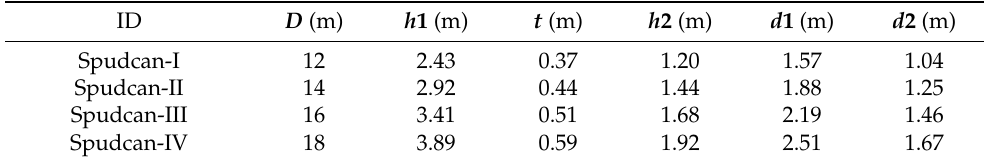
Table 1. Dimensions of spudcans adopted in this